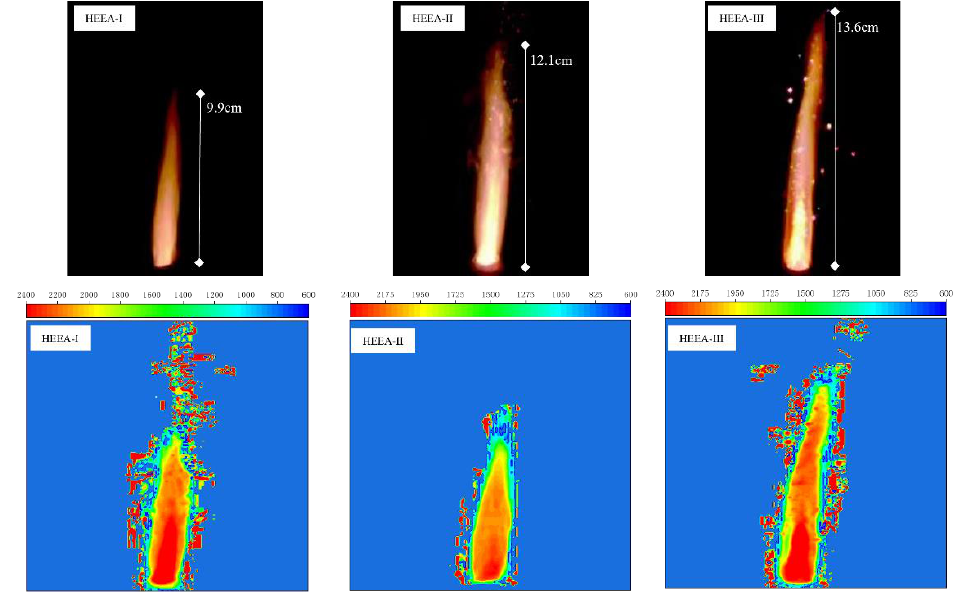
Figure 10. Flame characteristics and temperature distribution of high-energy expansion agent.